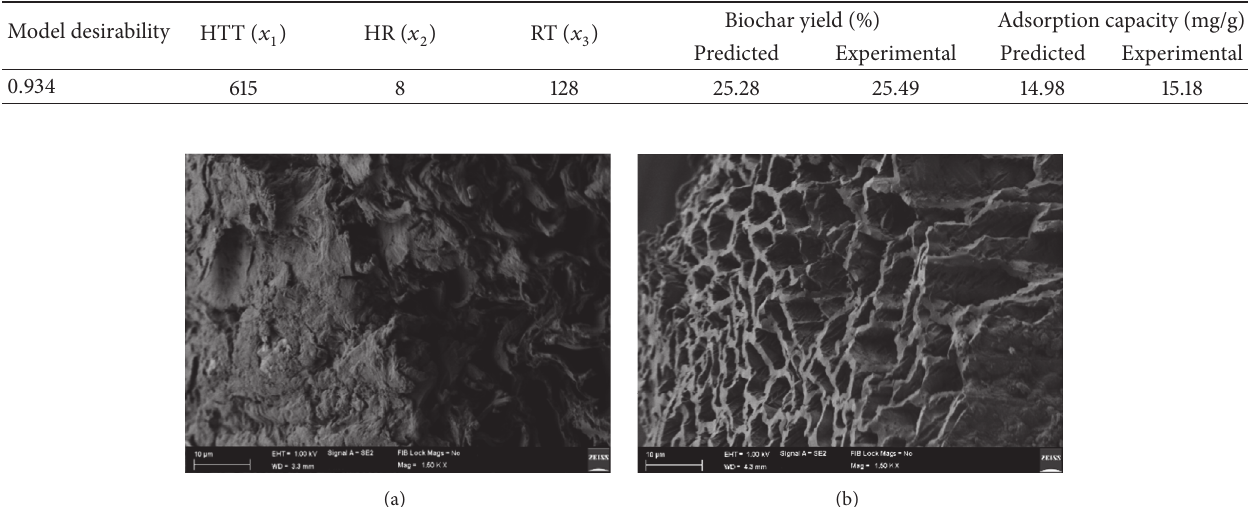
Figure 5: (a) SEM image of oil palm empty fruit bunches. (b) SEM image of OPEFB biochar produced under optimum